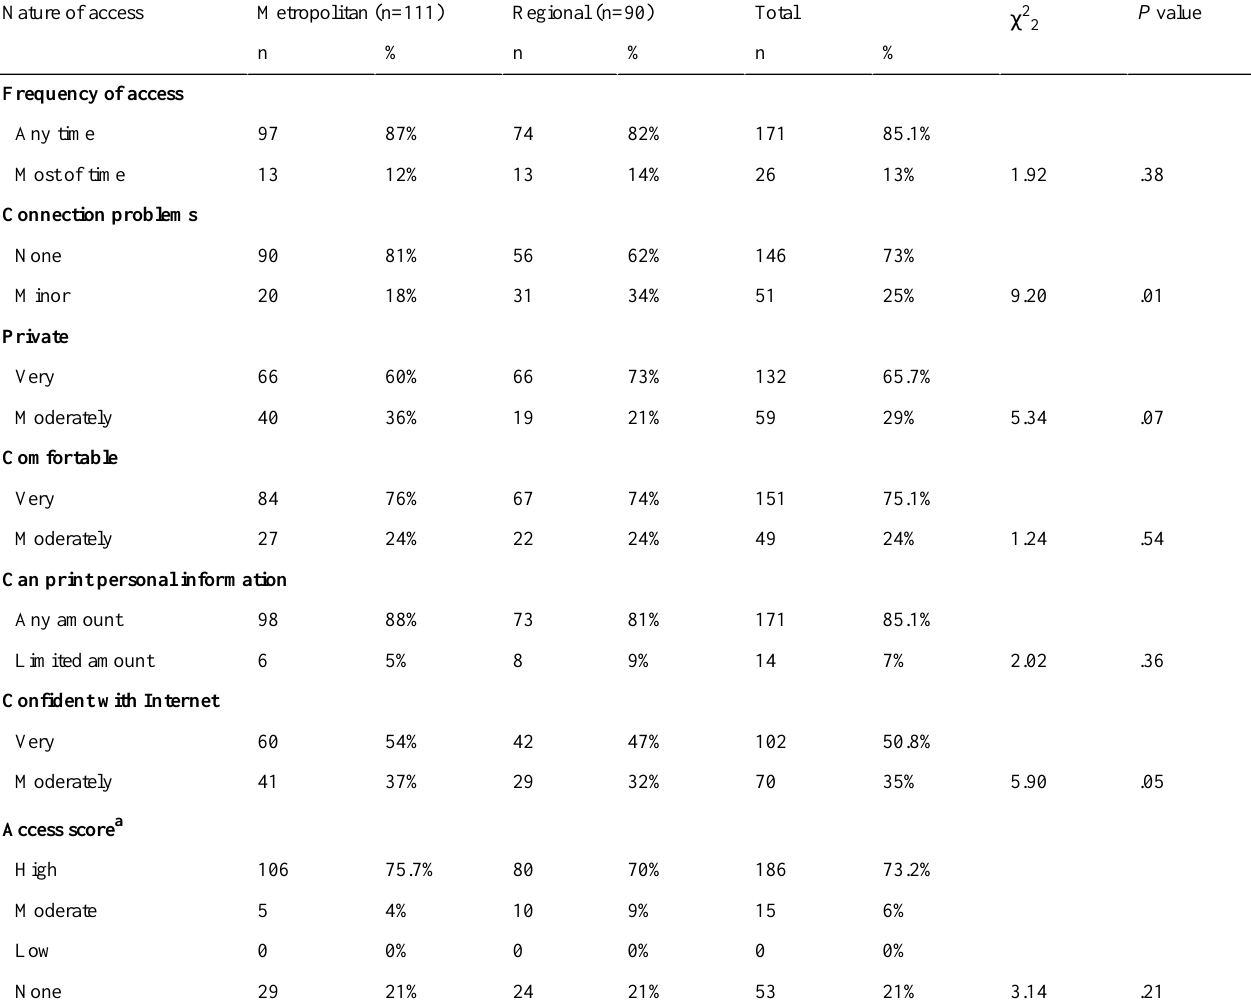
Table 2. Nature of Internet access for those with access who answered all the access questions (n = 201), and overall level of access for whole sample (n = 254)